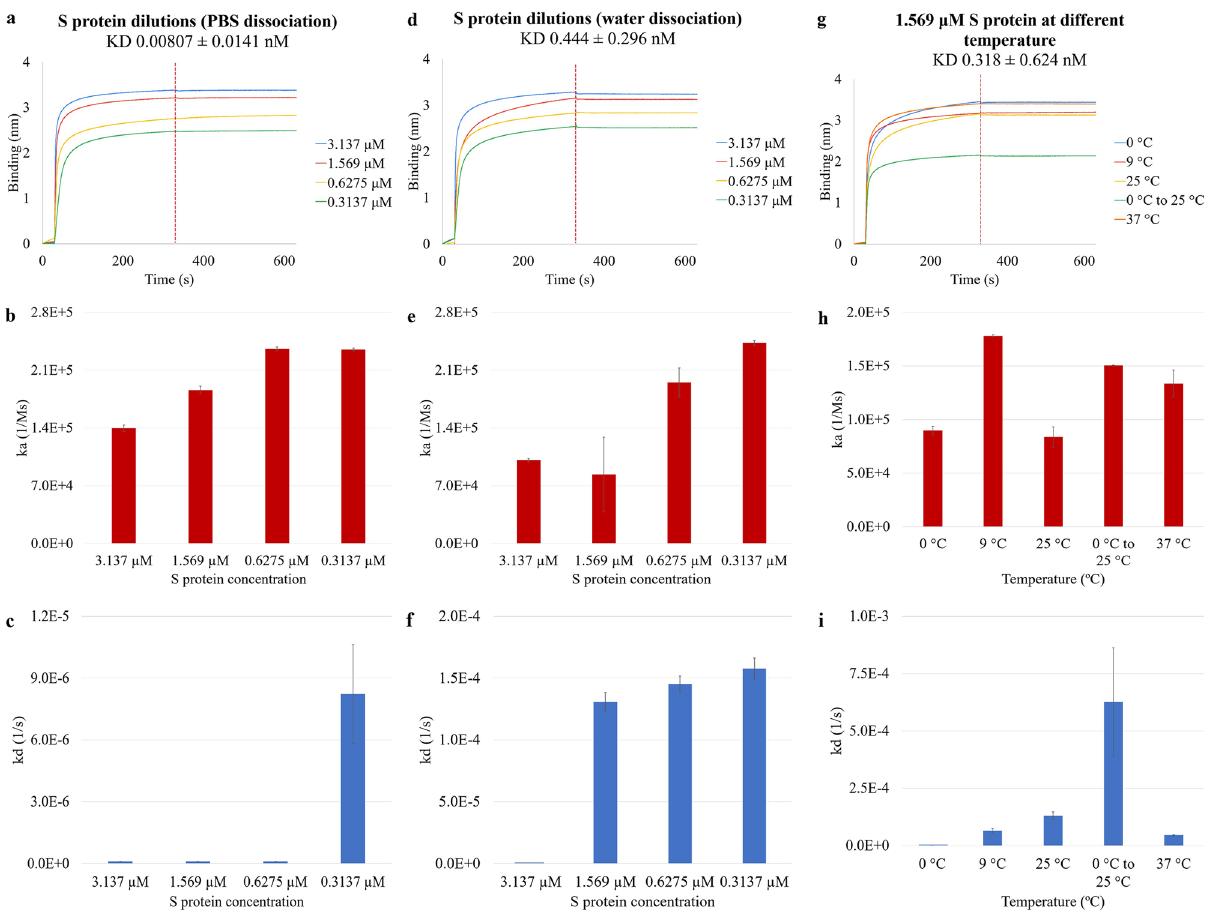
Figure 1. The effects of protein concentrations, ionic PBS dissociation, water dissociation, and temperature on the attachment and detachment of S protein to and from the hydrophobic APS sensors. The binding curves were generated from the basic kinetics analysis of 3.137 µM, 1.569 µM, 0.6275 µM, and 0.3137 µM S protein dissociating ( a ) in PBS and ( d ) in purified water, and ( g ) 1.569 µM S protein at 0 °C, 9 °C, 25 °C, 0 °C to 25 °C, and 37 °C dissociating in water. The vertical dotted line on the figures indicates the end of the association or the start of the dissociation step. The association constant ka was shown for the four S protein concentrations dissociating ( b ) in PBS and ( e ) in water, and ( h ) for 1.569 µM S protein at 0 °C, 9 °C, 25 °C, 0 °C to 25 °C, and 37 °C dissociating in water. The dissociation constant kd was shown in the same order for the three groups of conditions in ( c ), ( f ), and ( i